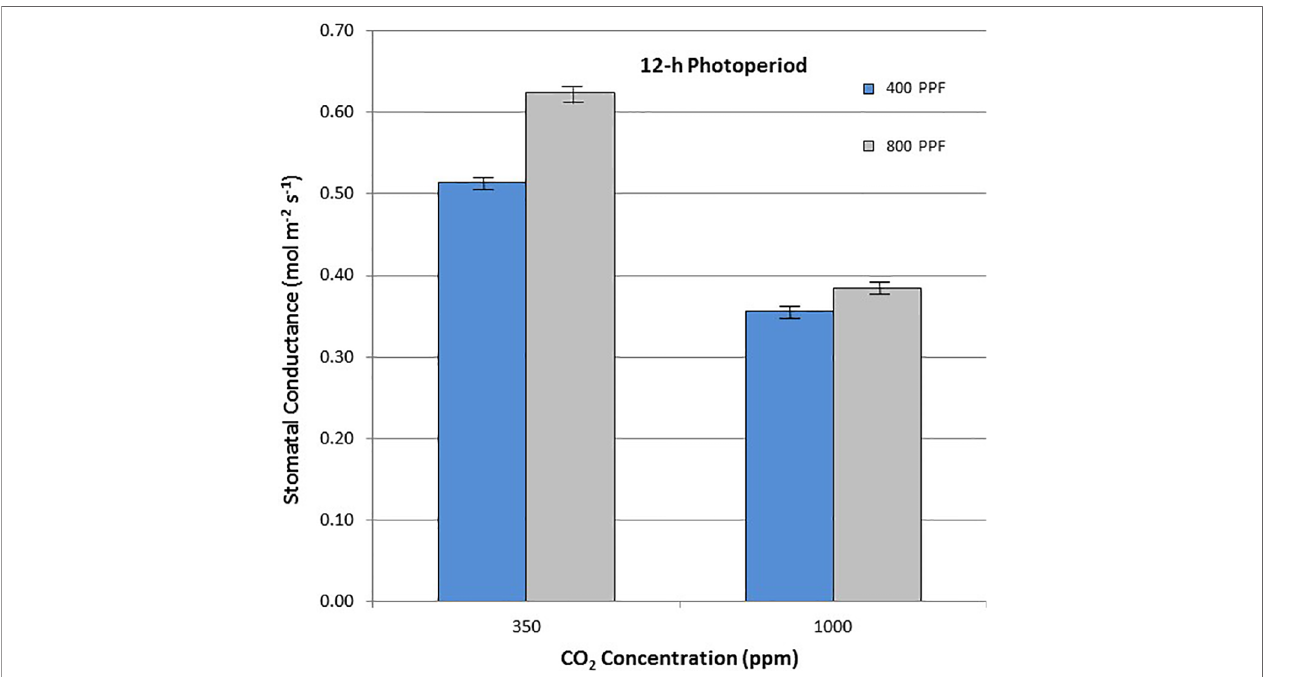
FIGURE 8 | Comparison of time-averaged stomatal conductance rates taken at 21, 28, 35, 42, 56, 70, and 84 days after planting for all cultivars grown under a 12- h photoperiod at two [CO 2 ] concentrations, and two photosynthetic photon fl ux (PPF) levels. A total of n = 36 measurements were taken at each of the 7 dates, for a total 252 total measurements. Error bars indicate the standard error of the mean for average measurements at each date.